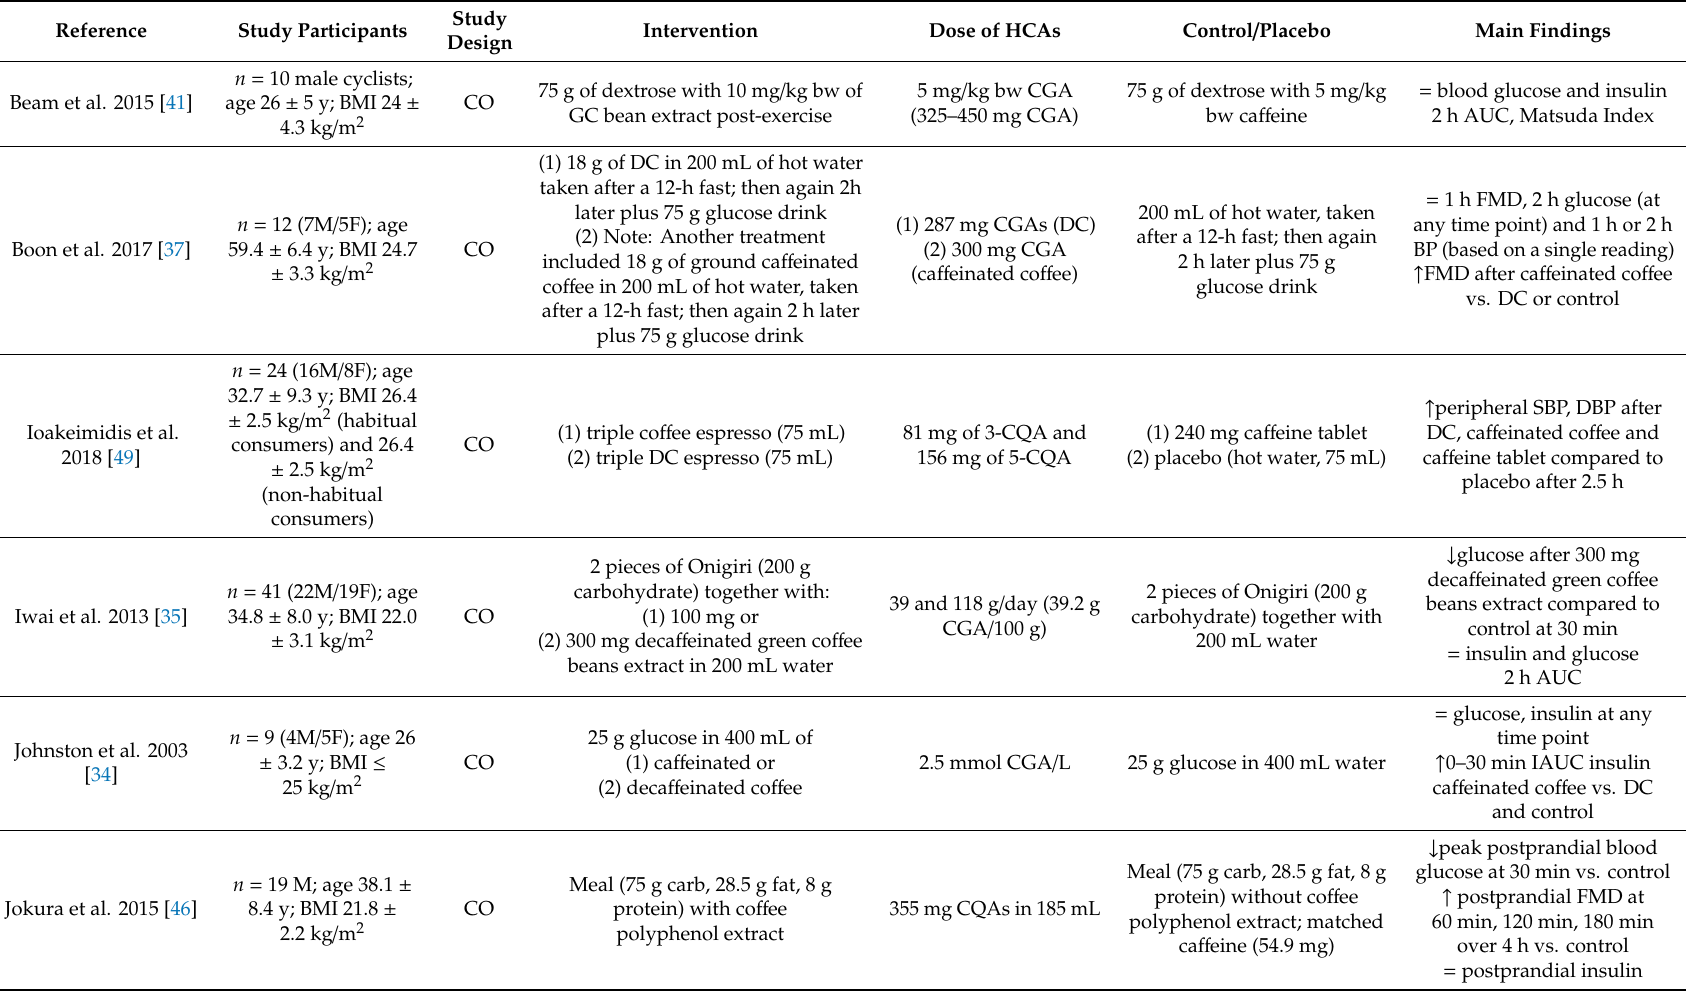
Table 1. Characteristics of the included acute intervention studies investigating the e ff ect of HCA-rich foods on cardiometabolic